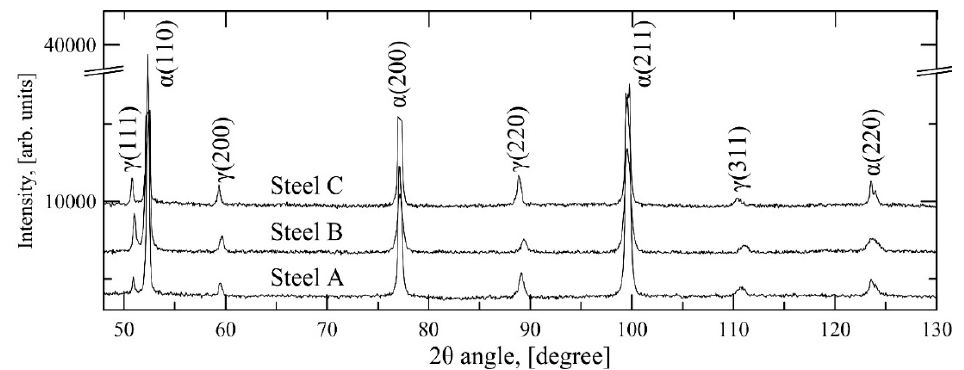
Figure 5. The observed XRD spectra for Steel A, quenched to 175 °C, Steel B, quenched to 300 °C and Steel C, quenched to 100 °C. All specimens were annealed at 850 °C for 4 min and partitioned at 450 °C for 100 s.